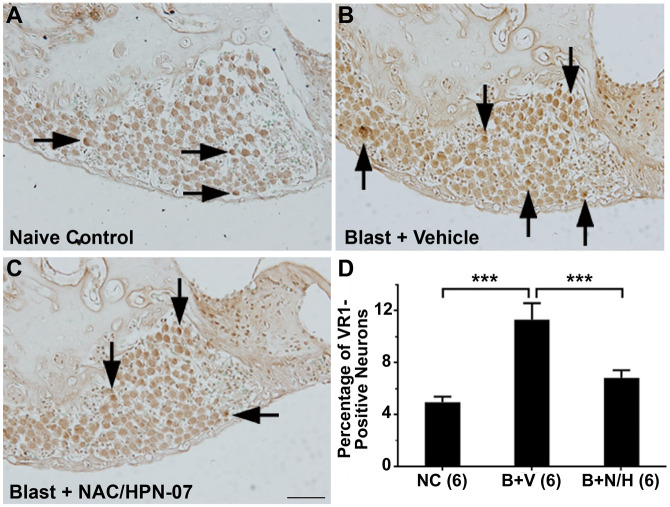
NAC/HPN-07 treatment attenuated chronic blast-induced up-regulation of VR1 in spiral ganglion neurons.Examples of VR1 immunostaining in spiral ganglia from the naive control group (A), the vehicle-treated, blast-exposed group (B) and the blast-exposed, therapeutic-treated group (C). The number of VR1-positive SGNs were counted and statistically analyzed (D). Statistical significance was determined by ordinary one-way ANOVA (Tukey correction for multiple comparisons). A significantly increased number of VR1-positive neurons were observed in the SG of the vehicle-treated, blast-exposed group (B+P) compared to naive controls (NC, *** p < 0.001). A significant reduction in the number of VR1-positive SGNs was observed in blast-exposed rats treated with NAC/HPN-07 (B+T) compared to the vehicle-treated, blast-exposed group (B+P, *** p < 0.001). There was no significant difference in the number of VR1-positive SGNs between the NC and the B+T groups (p > 0.05). Numbers in parentheses represent the number of animals evaluated in each group. The scale bar in C = 50 μm, applies to A-C.